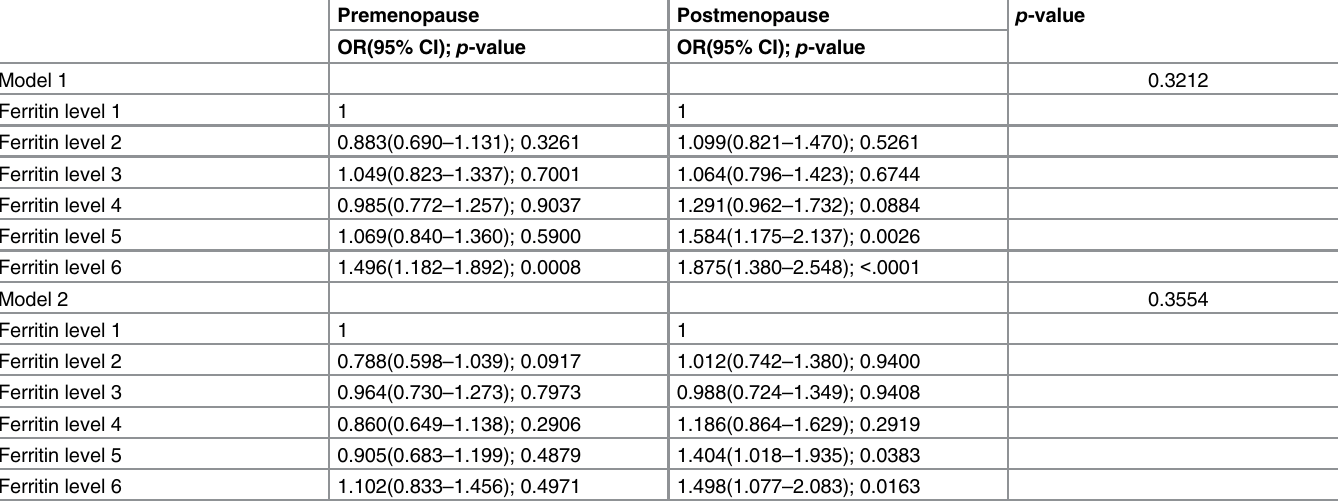
Table 5. Adjusted odds ratios (95% confidence interval) for WC/Ht ( (cid:1) 0.51) by serum ferritin groups